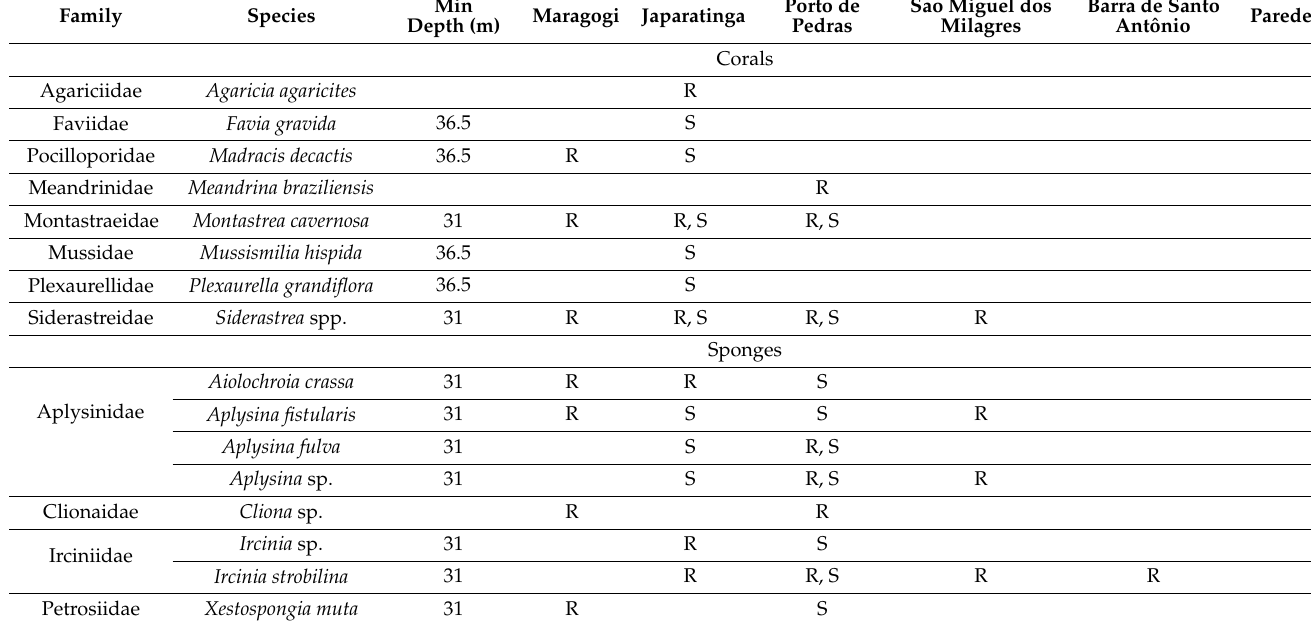
Table 3. Families and species of corals and sponges registered, with identification of the location, minimum depth recorded, and methodology used, in the mesophotic zone of Marine Protected Area Costa dos Corais, Brazil. Depth data available in Table S1 (Supplementary Material).